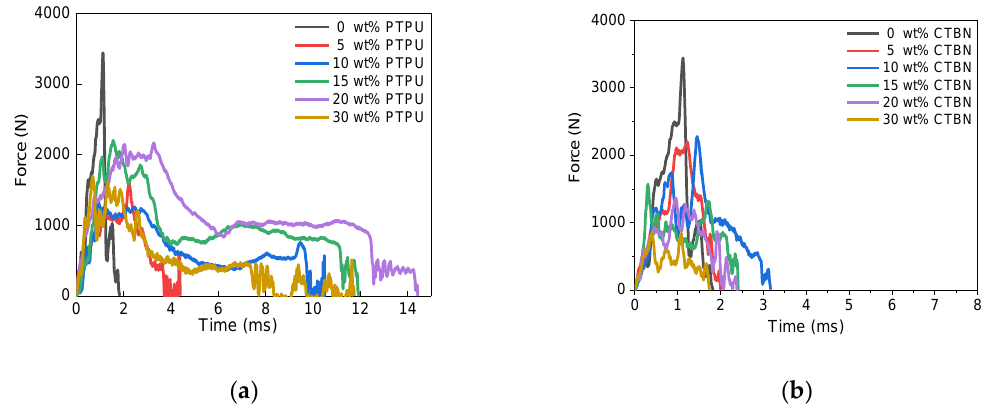
Figure 6. Time-to-force curves of the epoxy adhesives toughened with PTPU ( a ) and CTBN ( b ) measured by the IWP test method.